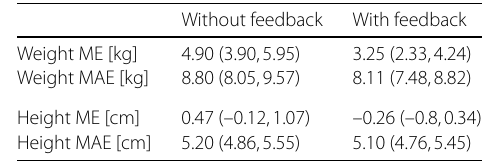
Table 5 Comparison of weight- and height-guessing results with vs. without feedback on the previous guess, with bootstrapped 95% confidence intervals (only workers from Europe and